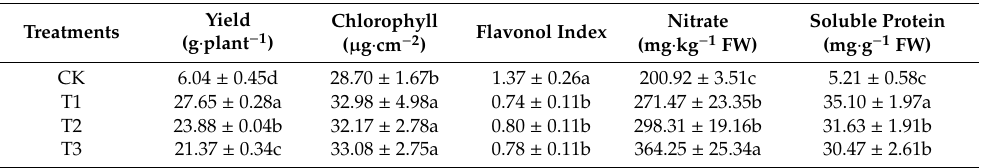
Table 2. Yield and quality of pakchoi after 42 days of